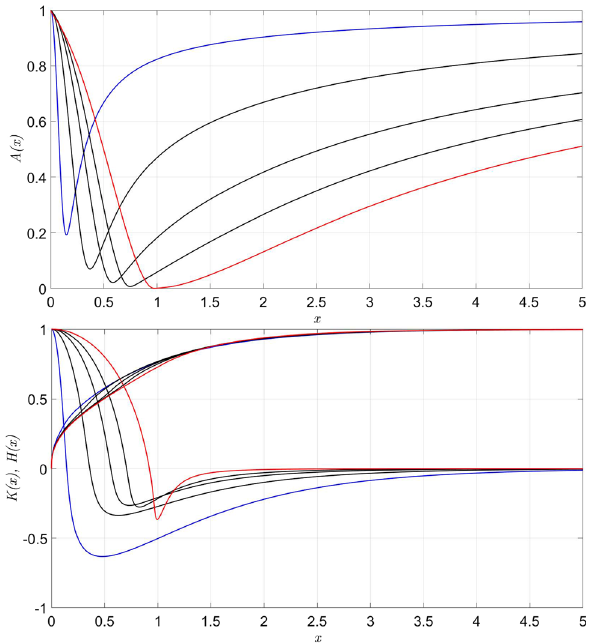
Fig. 2 Functions of A ( x ) , K ( x ) and H ( x ) versus x of the radial exci- tation for α = 0 . 2 (blue), 0 . 6 , 1 . 0 , 1 . 25 and 1 . 5 (red), for physical β and Weinberg